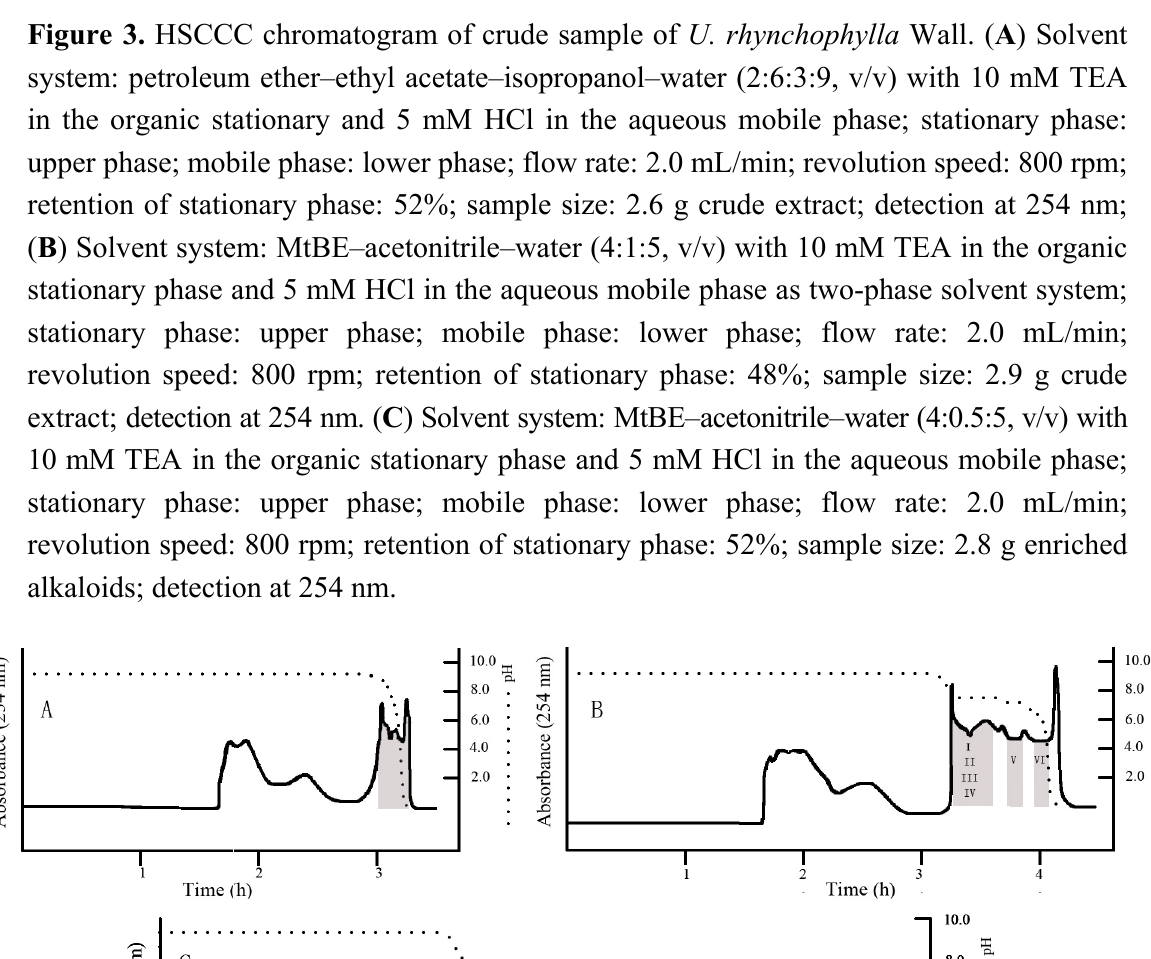
Figure 3. HSCCC chromatogram of crude sample of U. rhynchophylla Wall. ( A )